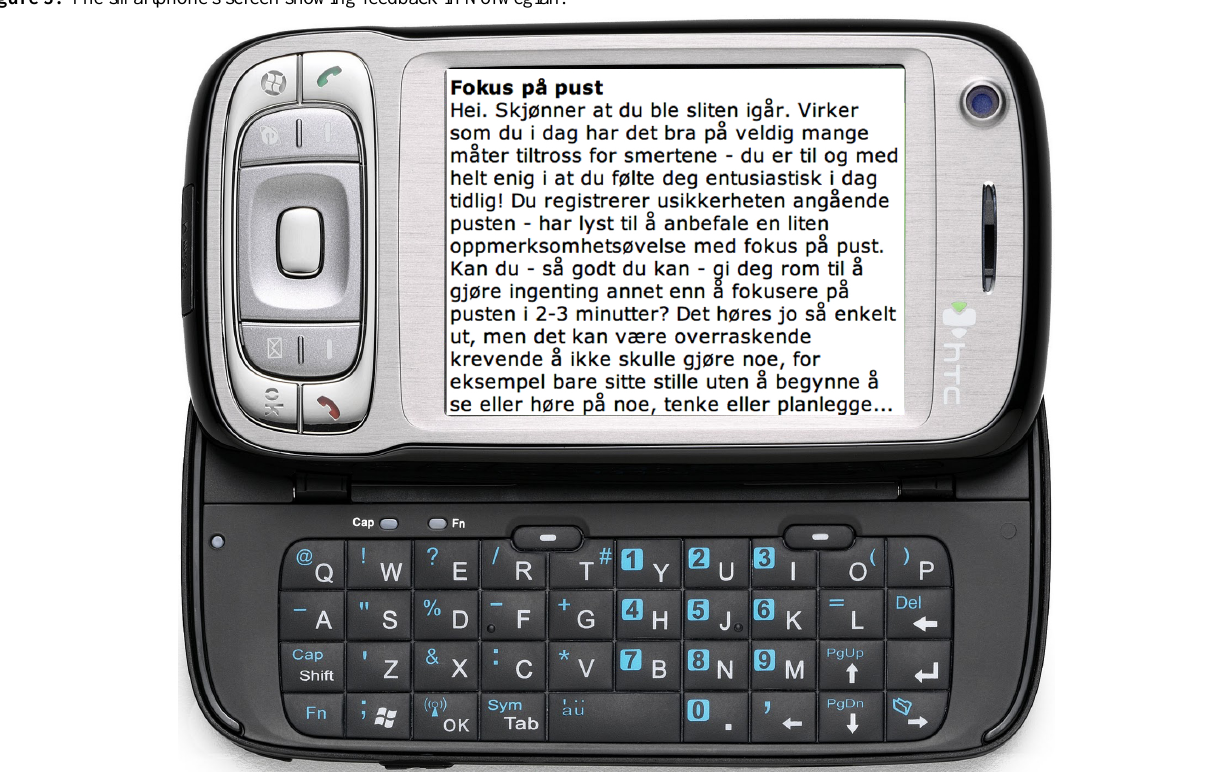
Figure 3. The smartphone's screen showing feedback in